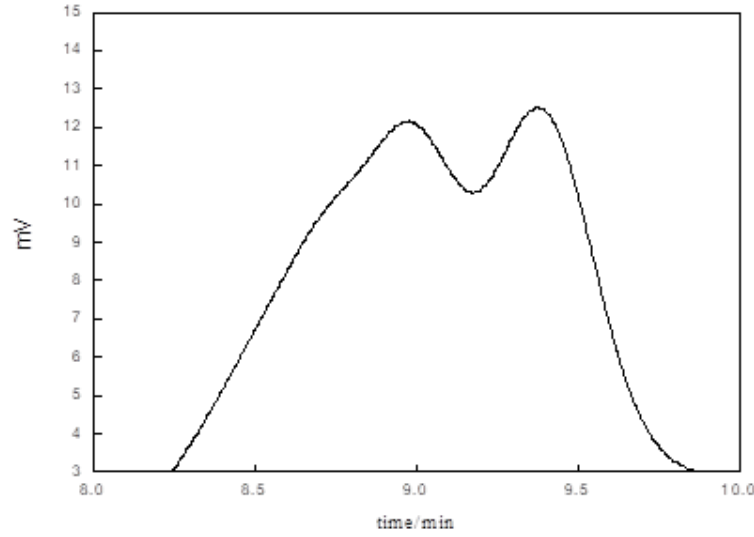
Figure 5. Gel Chromatography of water-borne polyurethane acrylate modified by hyperbranched